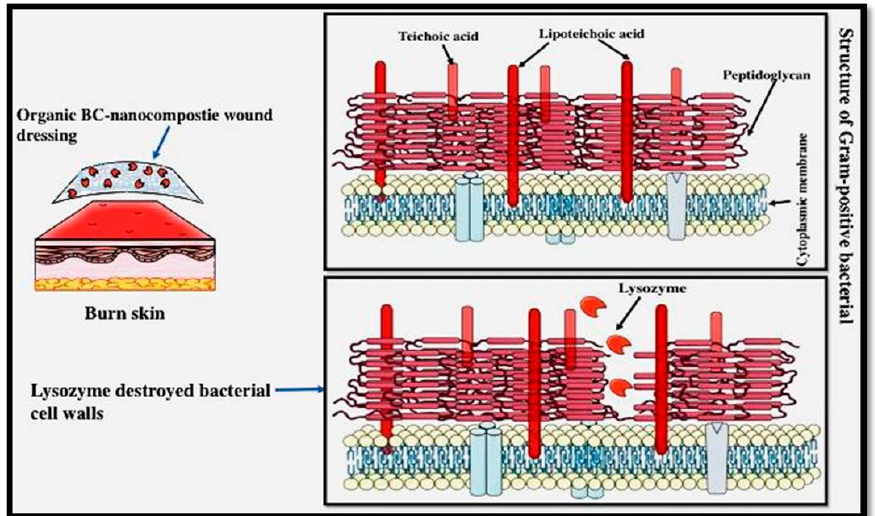
Figure 5. Organic nanocomposites for wound healing [11].